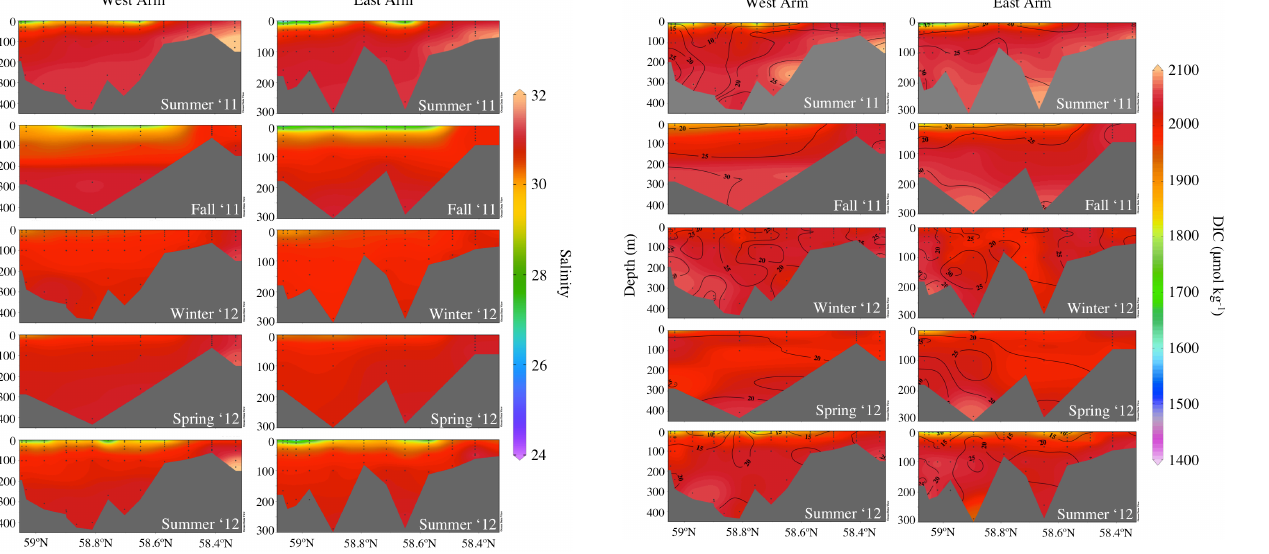
Figure 3. Spatial and seasonal distribution of salinity in the water column.